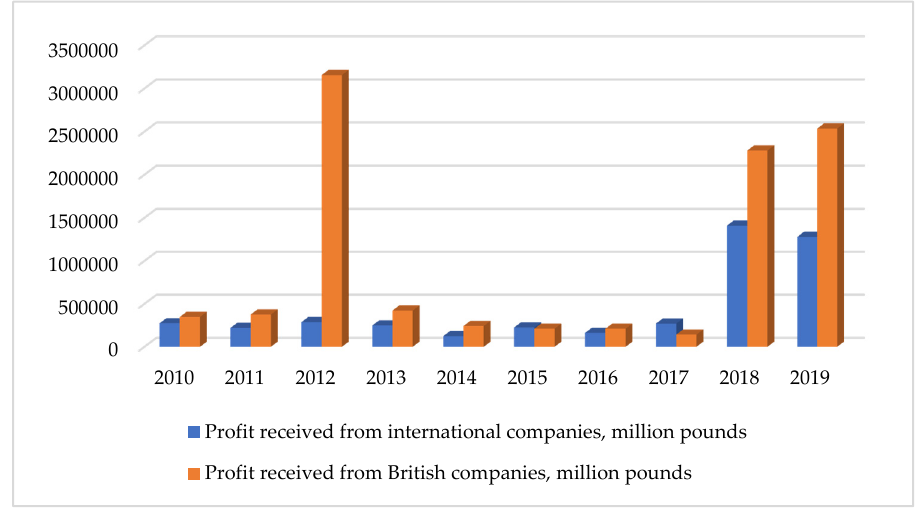
Figure 3. Dynamics of profit growth of the London Stock Exchange for 2010–2019. Compiled by the authors on the basis of London Stock Exchange (2021).